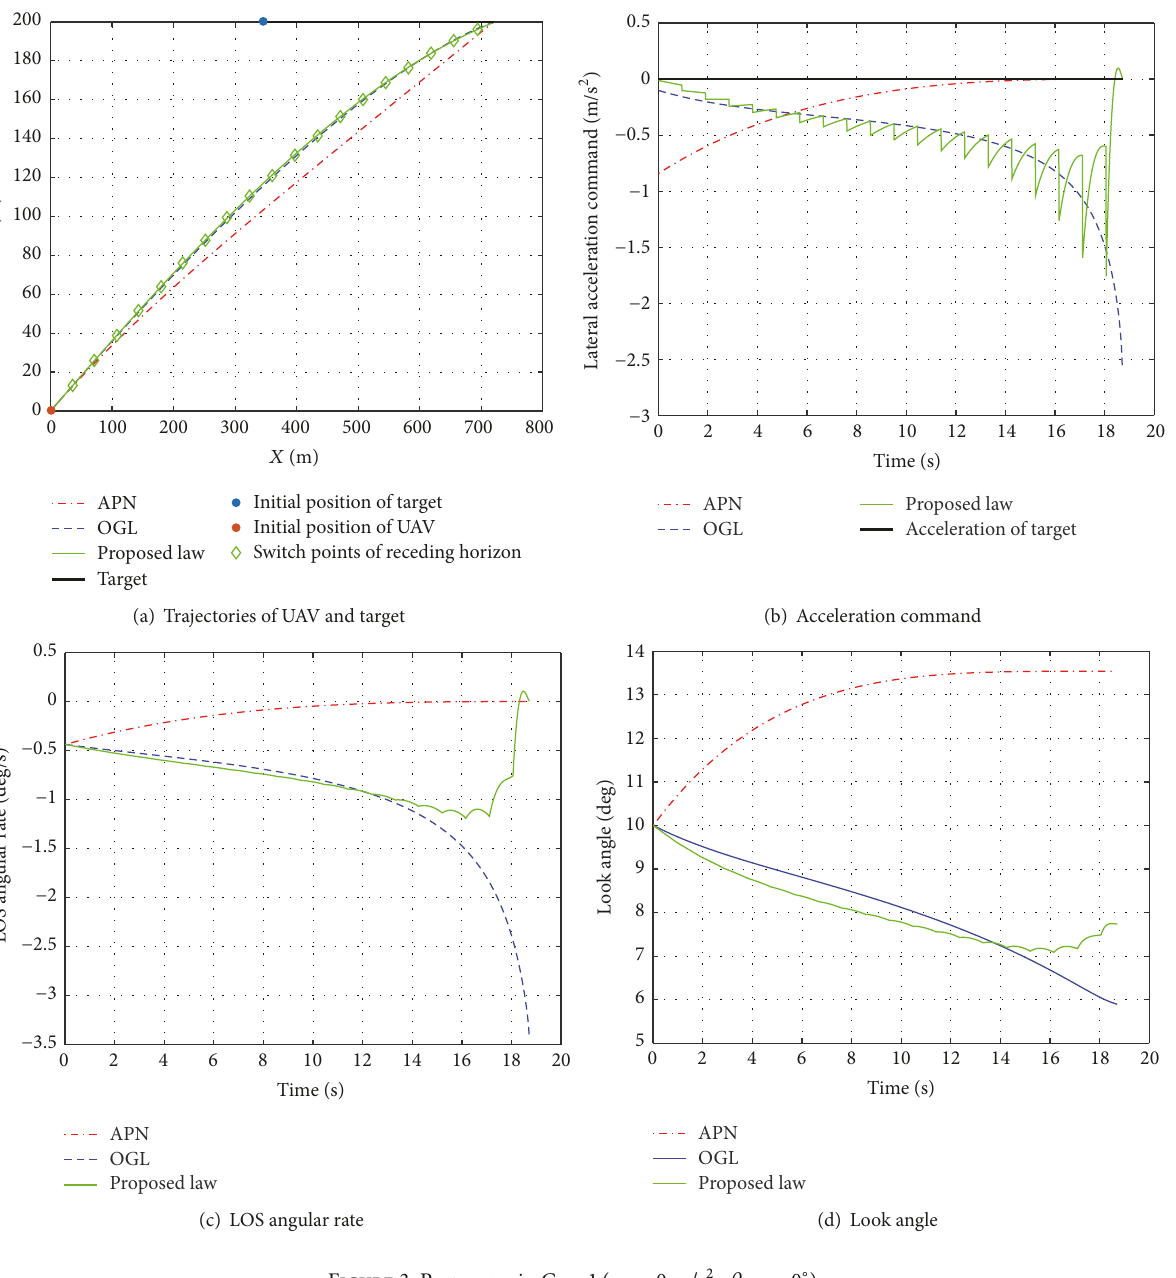
Figure 3: Responses in Case 1 ( 𝑎 𝑇 = 0 m / s 2 , 𝜃 𝑀0 = 0 ∘